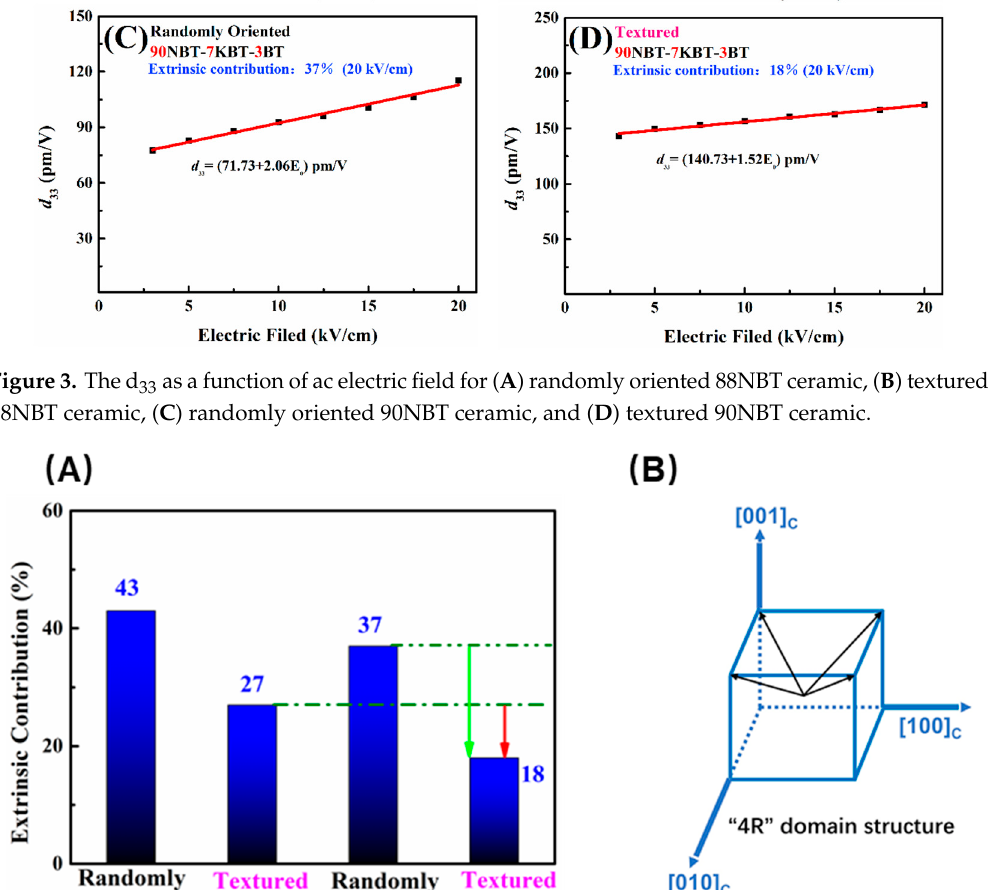
Figure 4. ( A ) The ratios of extrinsic contribution for randomly oriented 88NBT ceramic, textured 88NBT ceramic, randomly oriented 90NBT ceramic, and textured 90NBT ceramic. ( B ) The scheme of “4R” domain structure. The black arrow shows the possible domain vector in [001] poled rhombohedral single crystals.